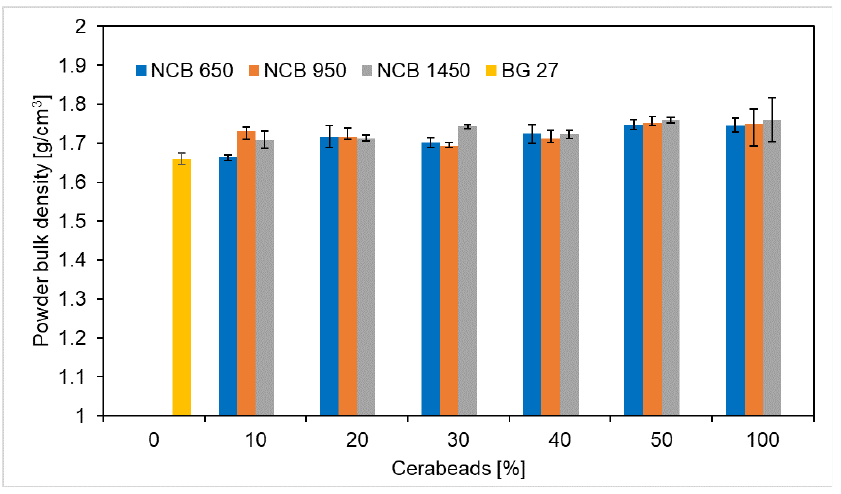
Figure 2. The trend of bulk density of hybrid mixtures as a function of CERABEADS content and its mean grain size.